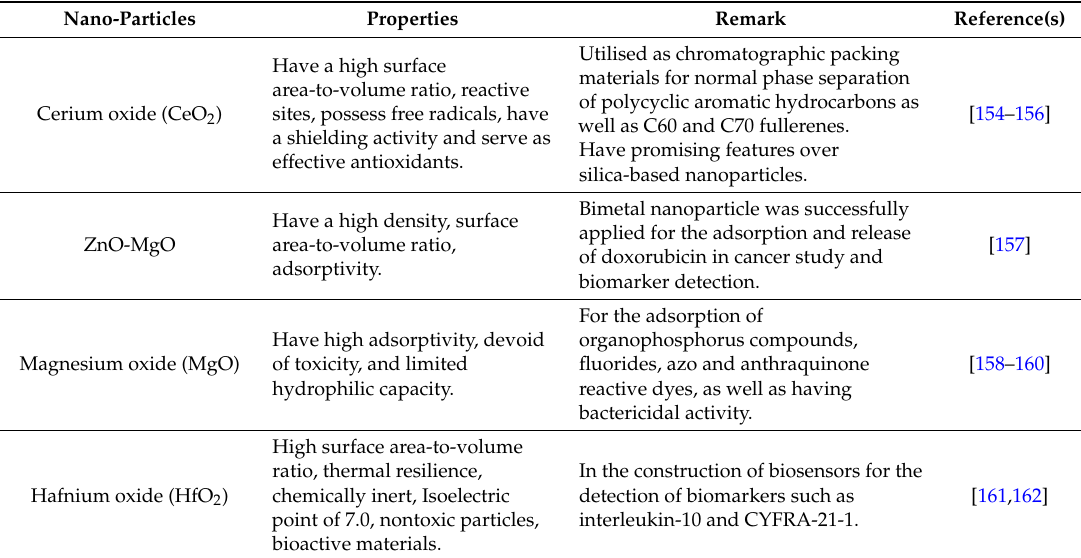
Table 2. Highlights of potential nanoparticles and their attributes for monolith